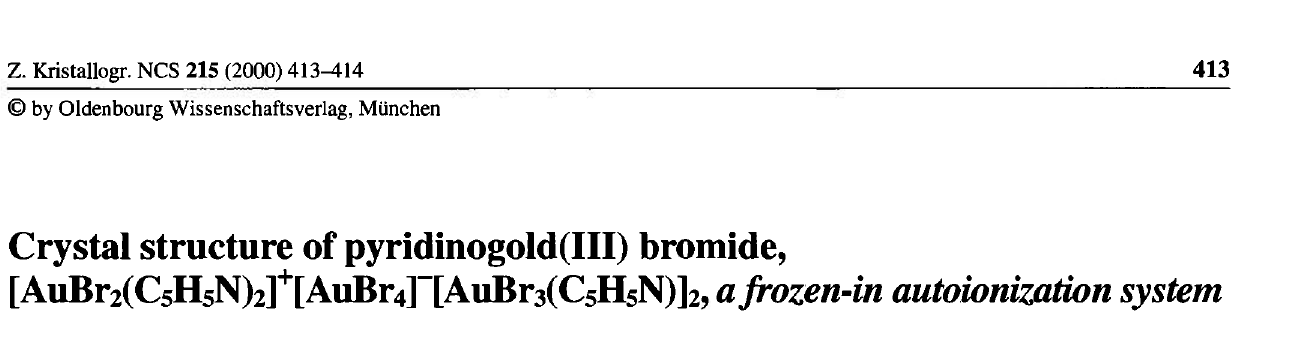
Table 1. Data collection and handling.